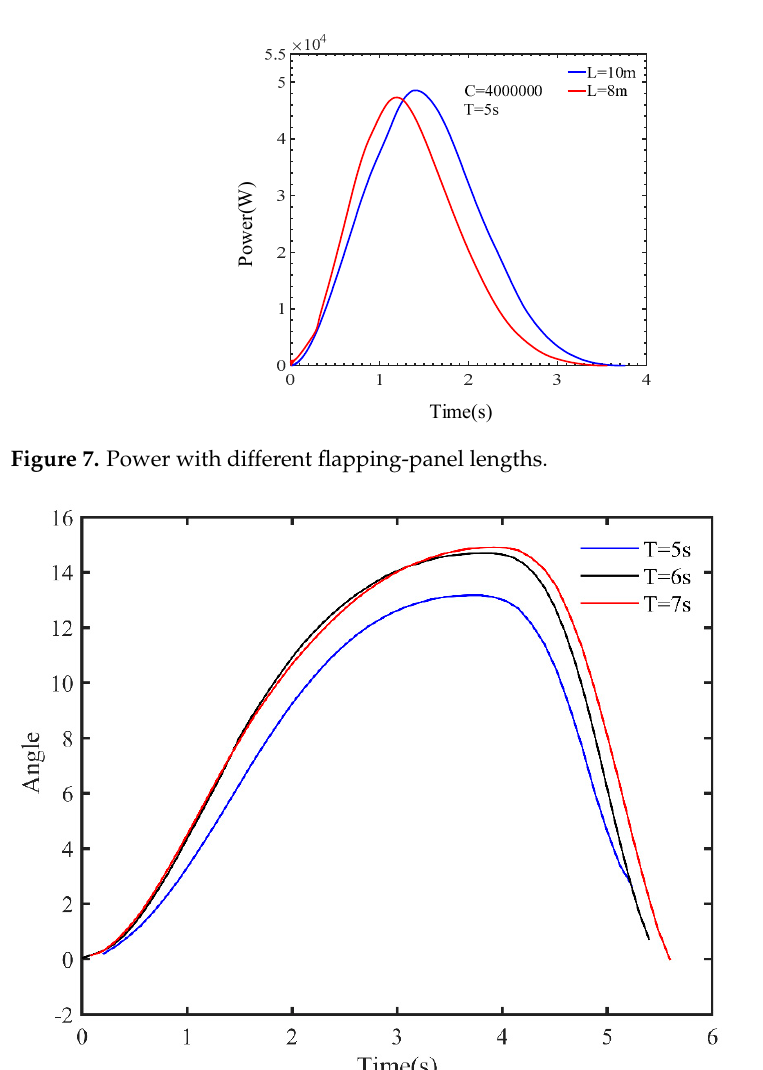
Figure 8. Floating swing angle over